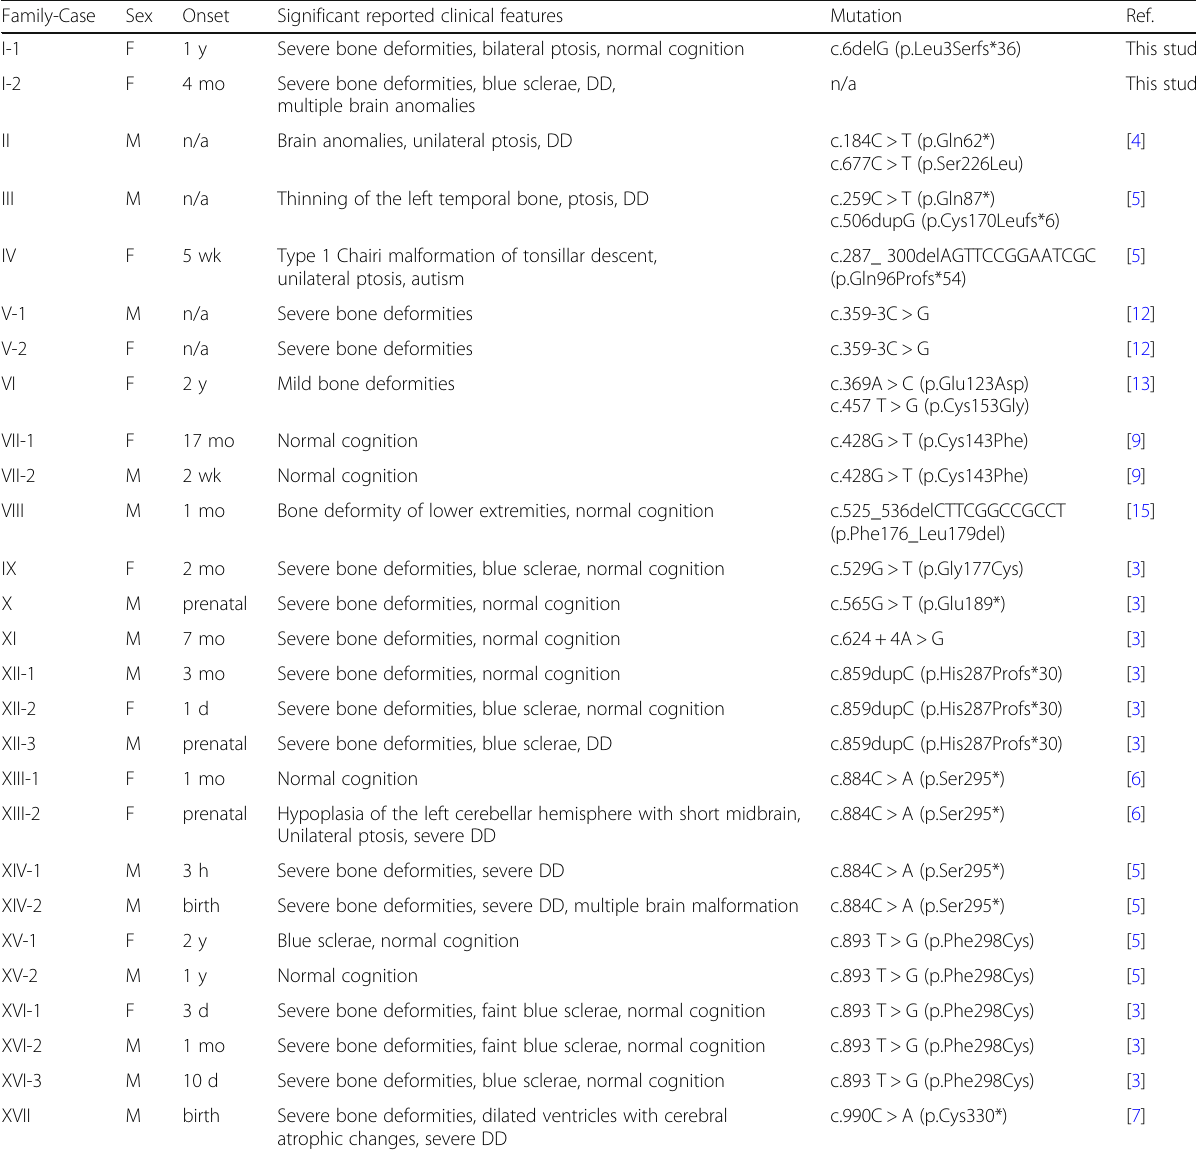
Table 1 Features of patients with WNT1 mutations (27 patients from 17 families)